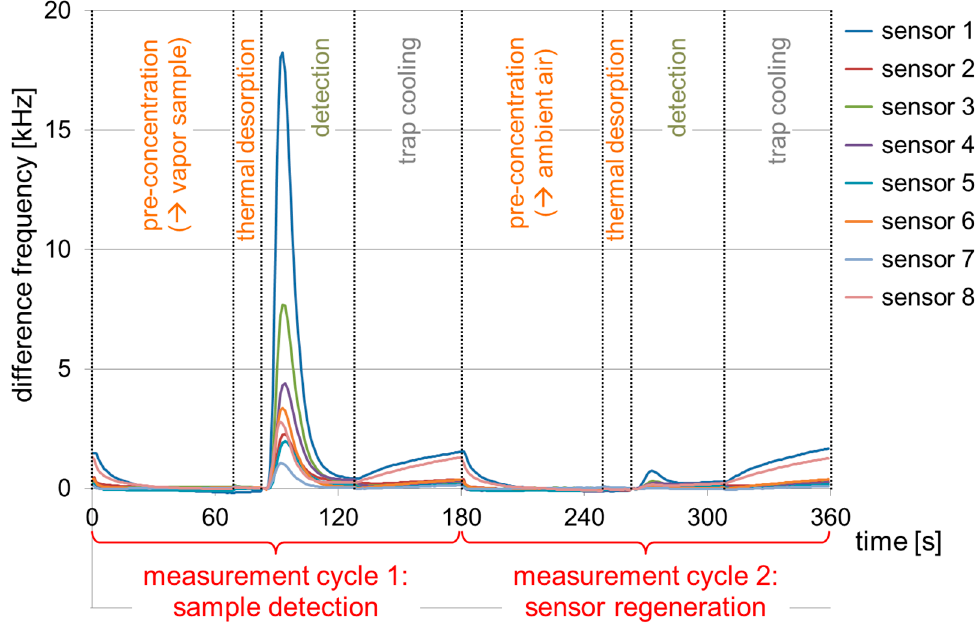
Figure 3. STW sensor array signal responses during measurement cycles for detection and regeneration. Chloroform, 11.6 ppmv, was used as exemplary sample. Dotted lines separate the cycle steps. Each cycle consisted of pre-concentration of gaseous sample (solvent vapor or ambient air) in the trap, thermal desorption, detection by the sensor array, and trap cooling.